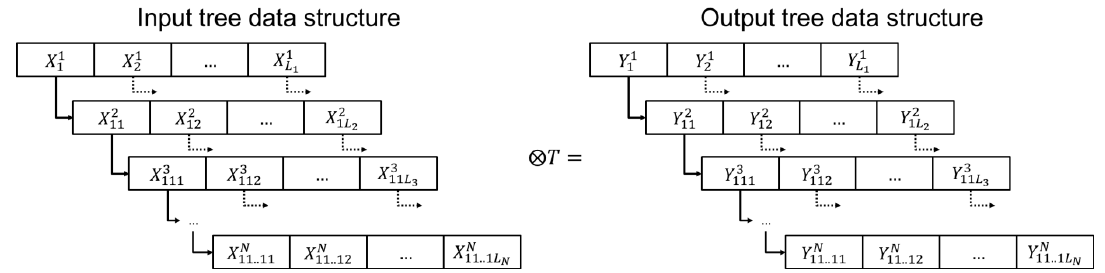
12 of 29 Figure 2. Tree data structure for storing interdependent multidimensional distributed parameters of solids in Dyssol. Here, each hierarchy level describes the distribution of material over a specific parameter, and each entry is the mass fraction of material that has a specific combination of parameters. Since distributions often contain a lot of zero values, such a structure can drastically reduce the amount of data, which needs to be stored and processed. In addition, this data structure allows the use of relative mass fractions for each level of the hierarchy, instead of operating with absolute mass fractions. Thus, from Figure 2 it follows that there are 30% of particles with a size of (2 mm 3 + 3 mm 3 )/2 = 2.5 mm 3 ; of these, 50% have a sphericity of (0.5 + 0.75)/2 = 0.625; and from them, 20% have a porosity of (0.33 + 0.66)/2 = 0.5. The total percentage of particles with this combination of parameters is 0.3 × 0.5 × 0.2 = 3%. The use of absolute mass fractions and tree structures allows for working with individual distributions without changing information in the others. So, transformation matrices can be